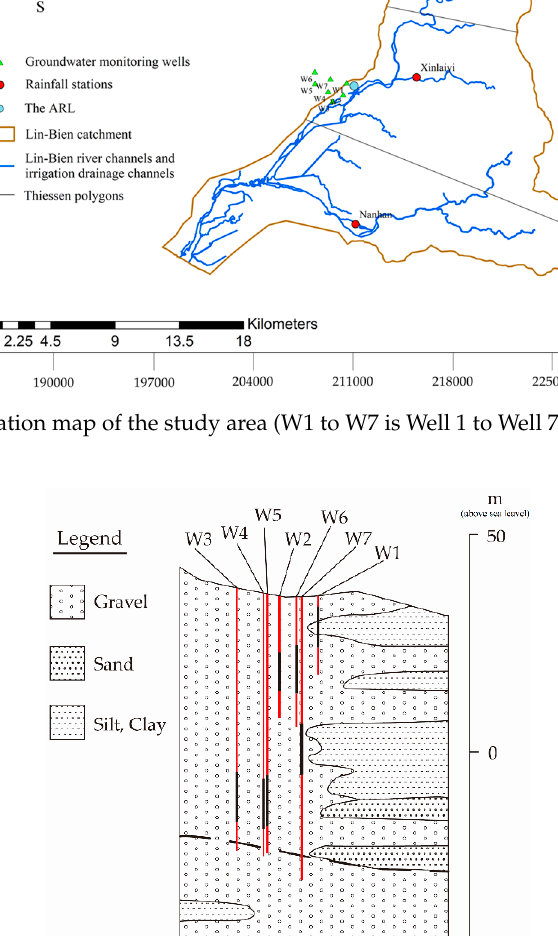
Figure 3. Hydrogeological profile of the study area (W1 to W7 is Well 1 to Well 7, respectively), after [25]. The A-A’ profile of Figure 1.